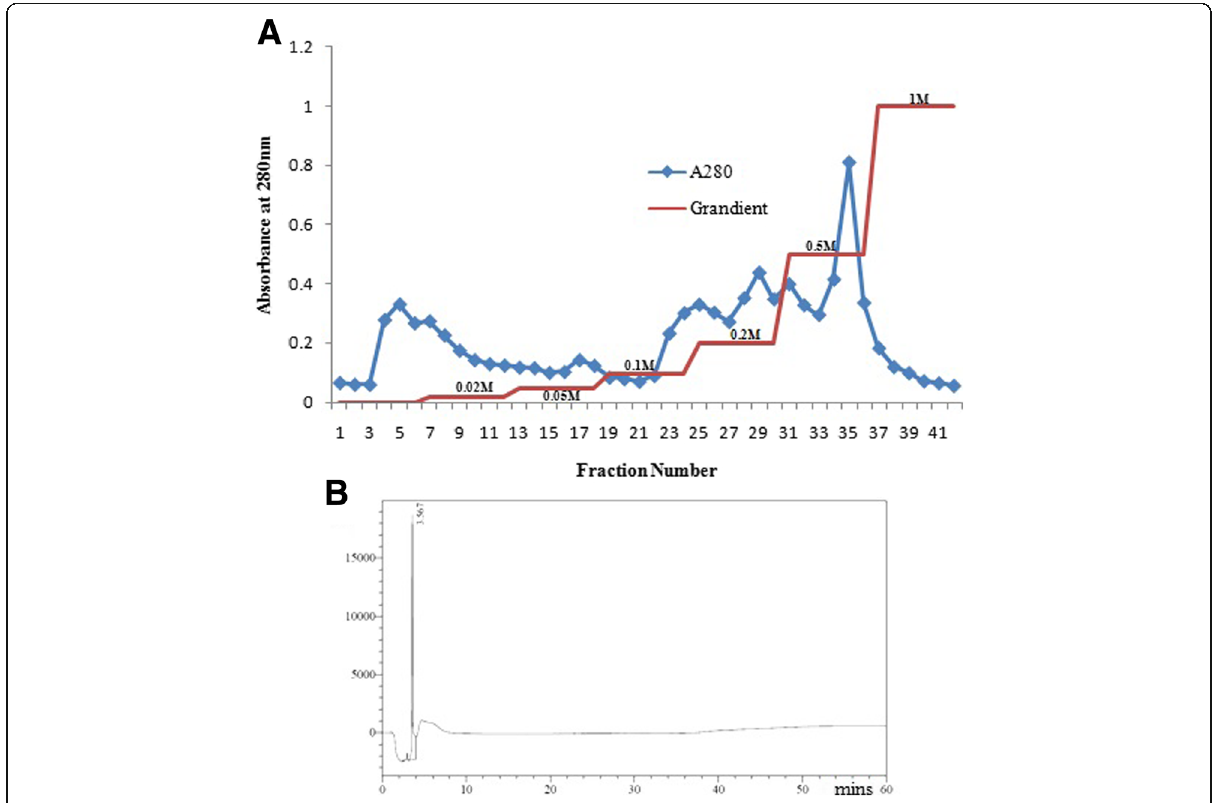
Fig. 1 a Purification of NN-32. An Ion exchange chromatography of Indian spectacled cobra ( Naja naja ) venom. b Peak eluted with 0.5 M NaCl solution was further purified by RP-HPLC. HPLC profile showed a single peak of NN-32 with a retention time of 3.6